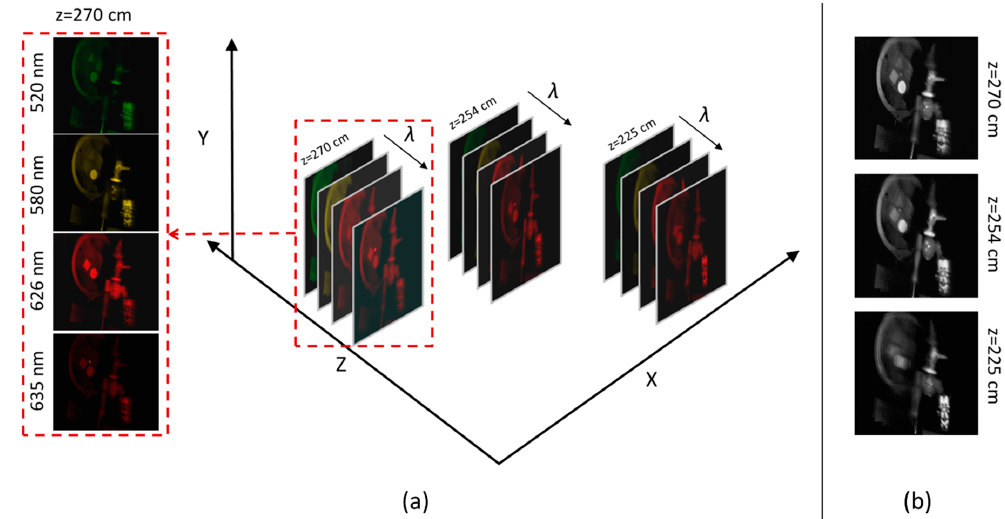
Figure 13. ( a ) 4D Spectro-Volumetric imaging. ( b ) Grayscale representation of HS images at three different depths (225 cm, 254 cm and 270